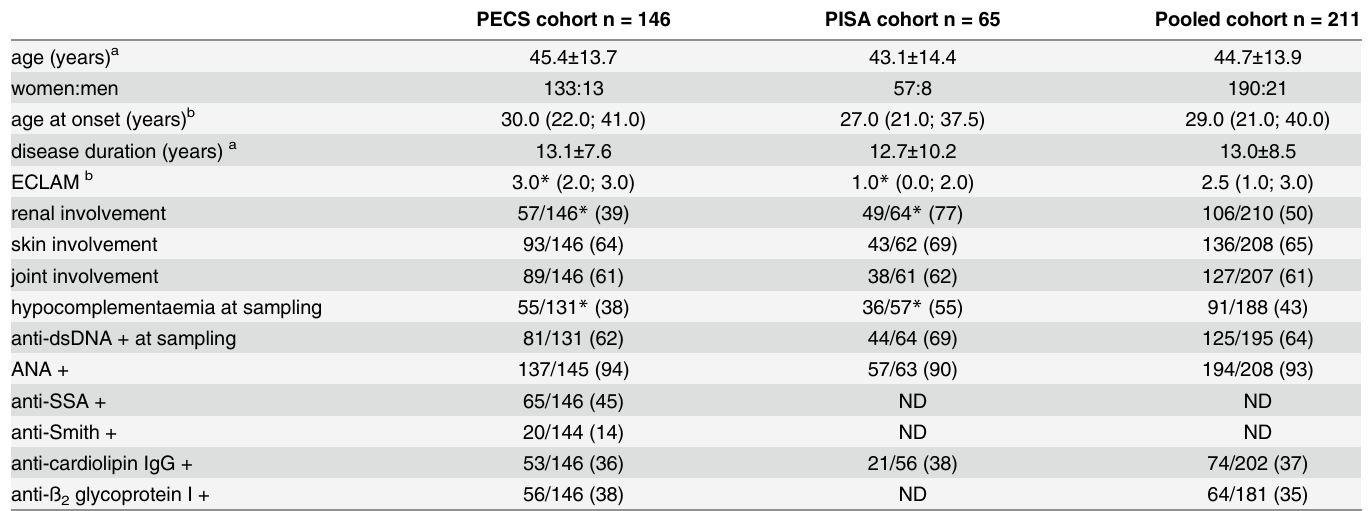
Table 1. Clinical and serological characteristics of the SLE patient